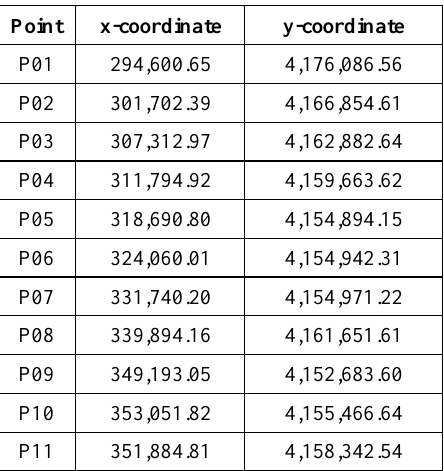
Table 1. Sample point locations